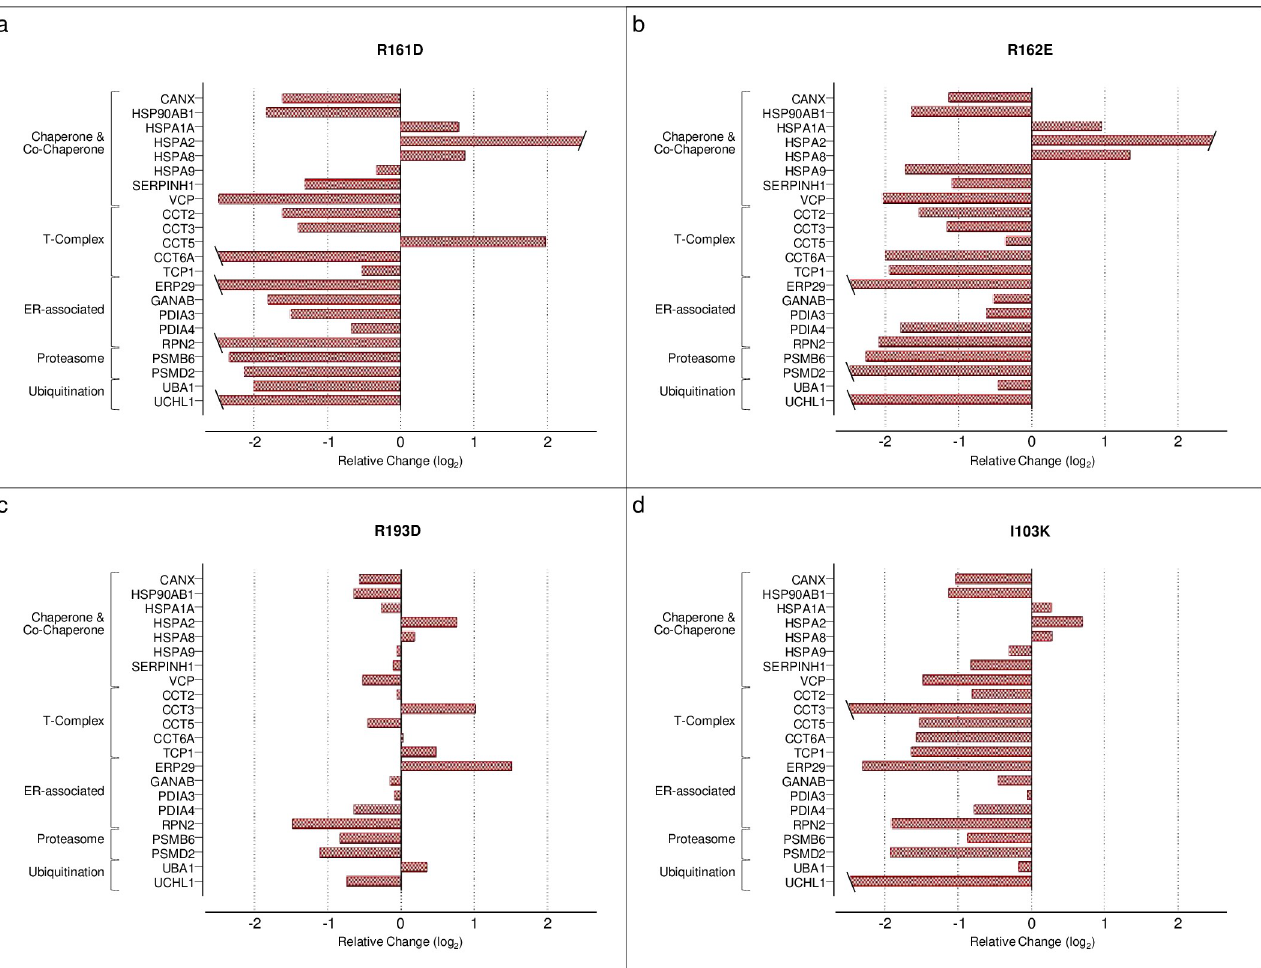
Fig 5. BAG and UbL mutants disrupt interaction of Bag-1 with protein quality control network. Protein abundances in the interactomes of TAP–Bag-1S mutants are compared to that of wild-type TAP–Bag-1S. Fold changes are depicted in log 2 base for a . R161D, b . R162E, c . R193D, and d . I103K mutants.